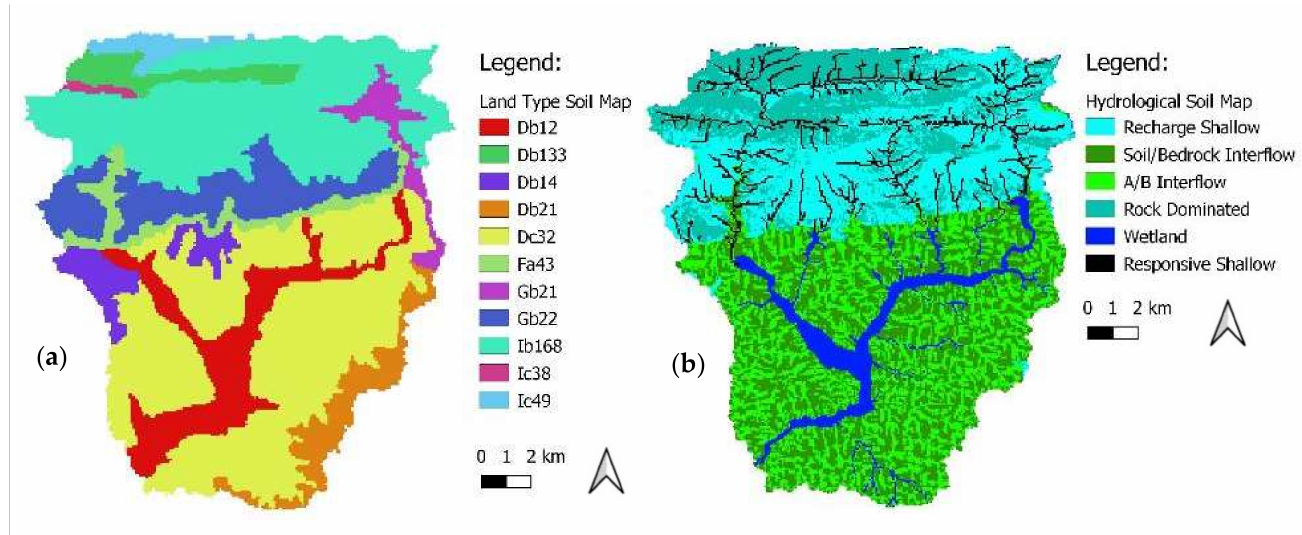
Figure 3. A spatial comparison of the two soil datasets, ( a ) LTSM and ( b )